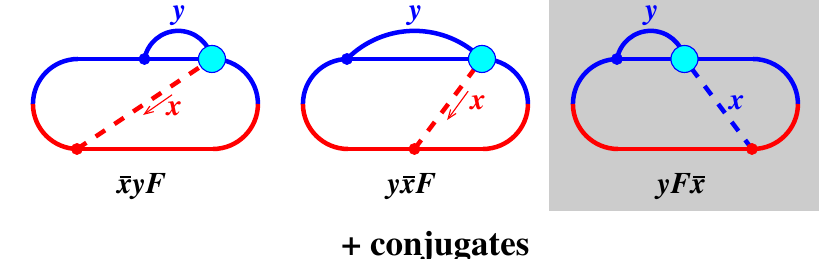
Figure 6 . Like figures 4 and 5 but for Class II virtual corrections to single splitting g → gg . Our terminology “Class II” [19] means that (i) y should be integrated over 0 < y < 1 for these diagrams and (ii) the diagrams are symmetric under x → 1 − x